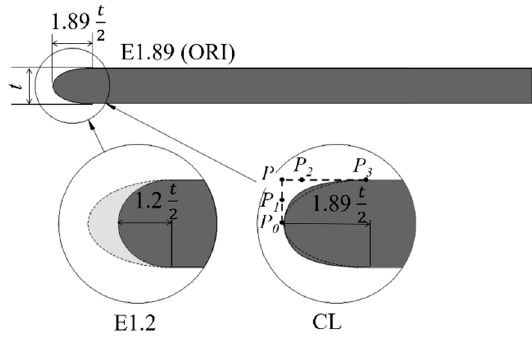
Figure 14. The different leading edge shapes.